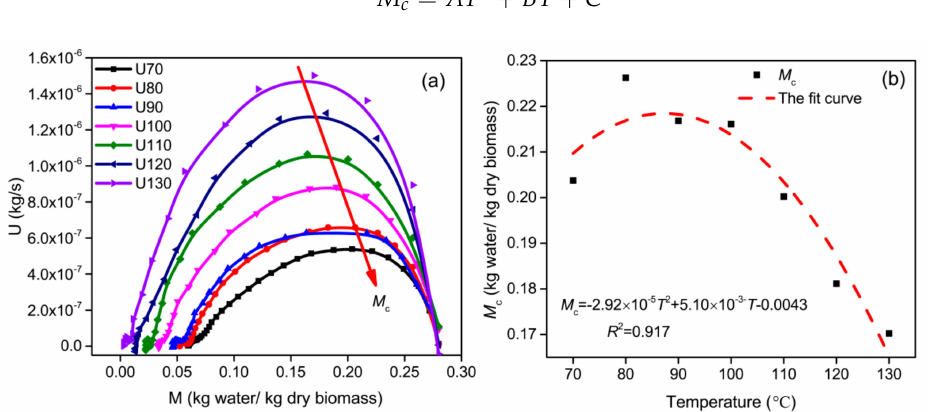
Figure 5. Distribution of critical moisture content for different drying temperatures: ( a ) the drying rate vs. the moisture content; ( b ) the critical moisture content vs. the drying temperature.